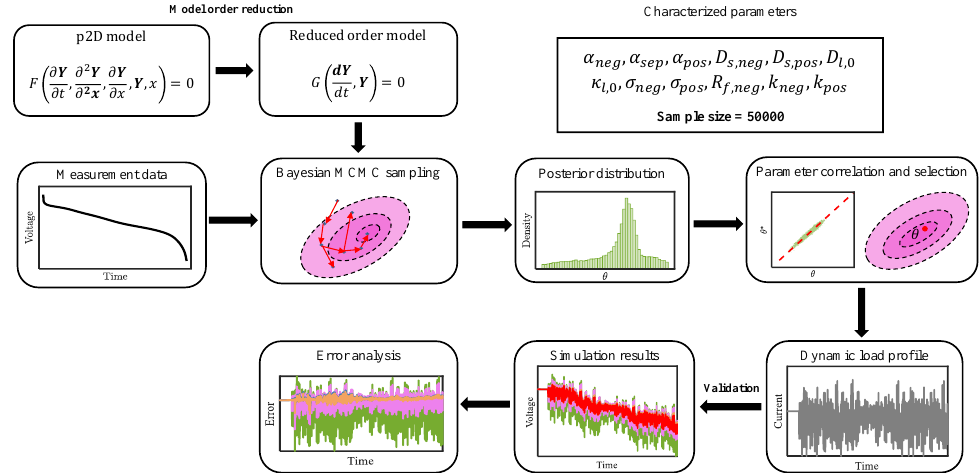
Figure 3. Workflow for the parameter identification and validation conducted in the present work. The different colors in the simulation results and error analysis sections represent the results of different test cases.